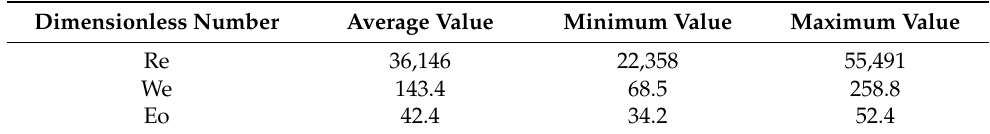
Table 4. Dimensionless Numbers for White Metal Conversion